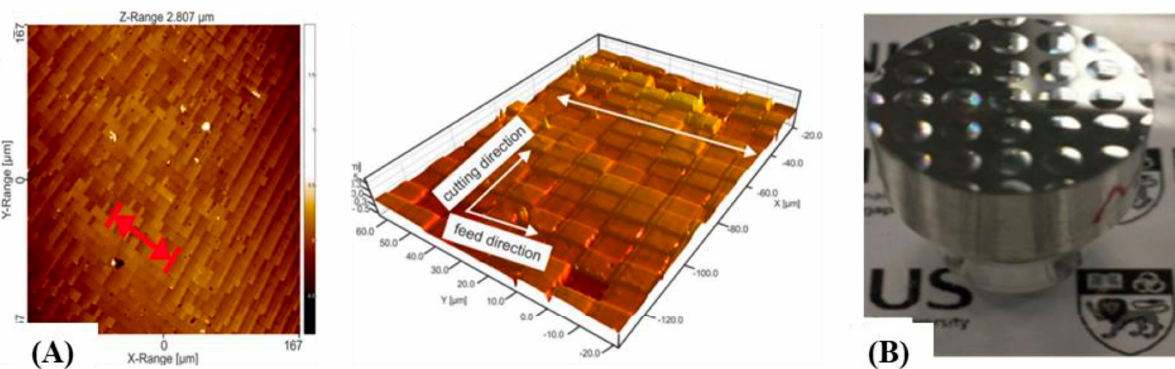
Figure 3. FTS machined workpiece examples. ( A ) FTS machined microstructured mold with a PMMA (polymethacrylate) surface embossed by the mold shown at right [31]; ( B ) Microlens array